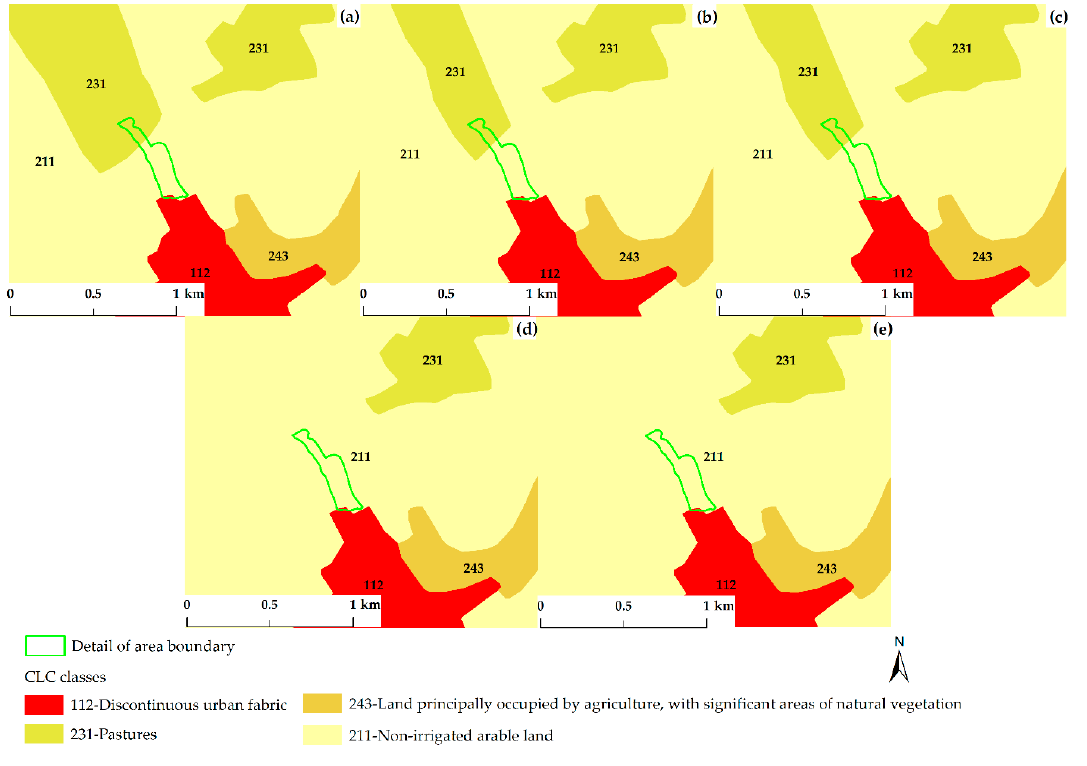
Figure 11. CLC changes over the period: ( a ) 1990; ( b ) 2000; ( c ) 2006; ( d ) 2012; ( e ) 2018.